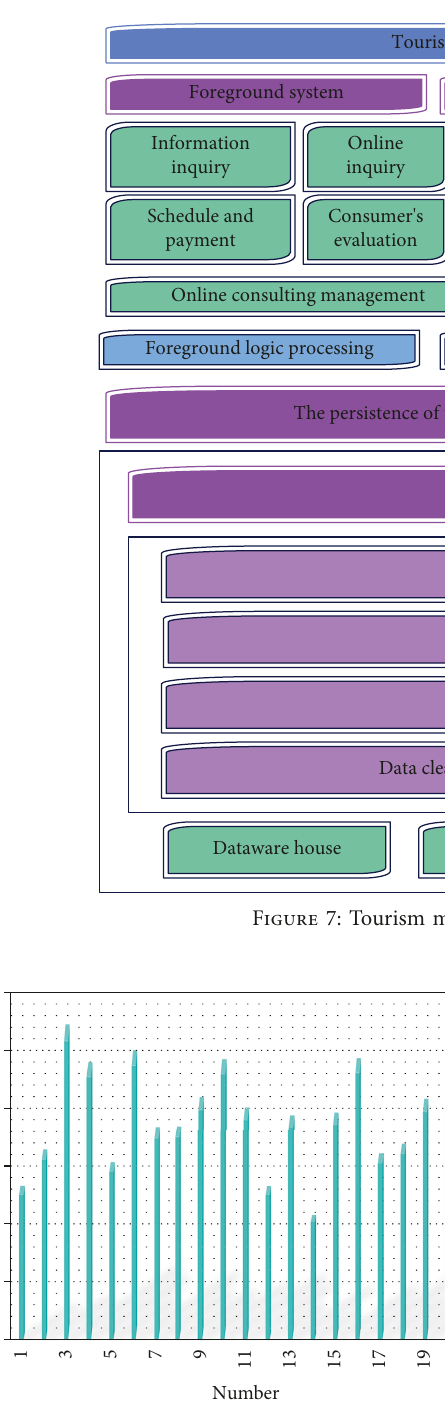
Figure 8: Tourism data management effect of tourism manage- ment system based on data